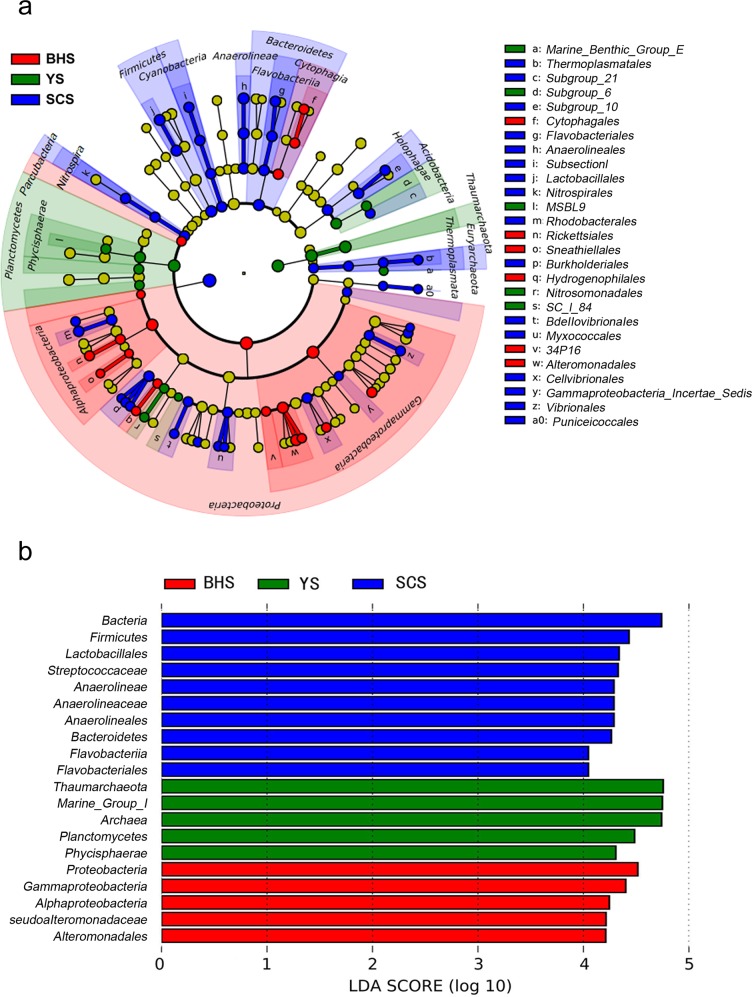
Taxonomic cladogram produced from LEfSe analysis.(A) Cladogram representing statistically significant differences in bacterial clades among the three sea areas. Small circles shaded with different colors in the diagram represent abundances of those taxa in the respective group (red, BHS; green, YS; blue, SCS; and yellow, nonsignificant). Each circle’s diameter is proportional to the taxon’s abundance. (B) Indicator of bacterial groups within the three seas of sediments with LDA score ≥ 4.